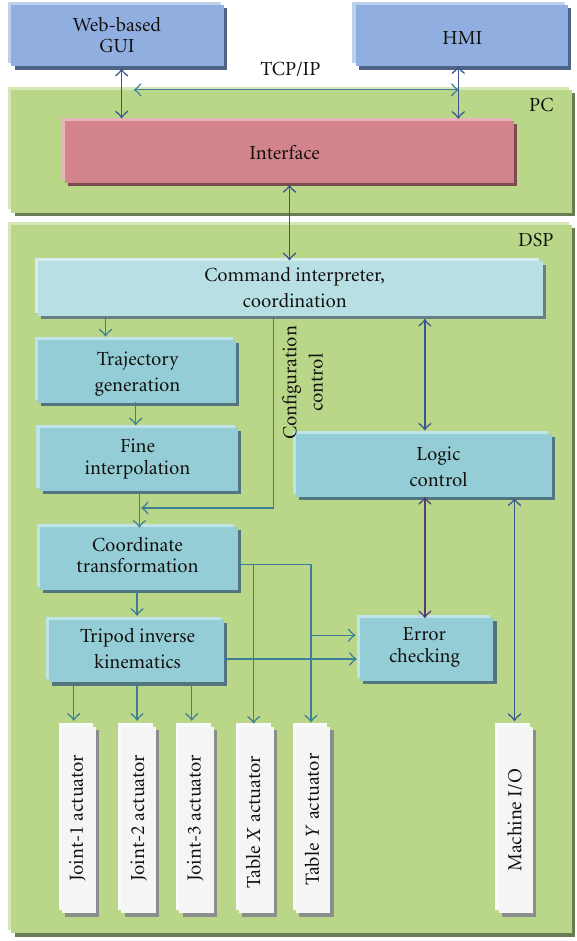
Figure 9: Control software